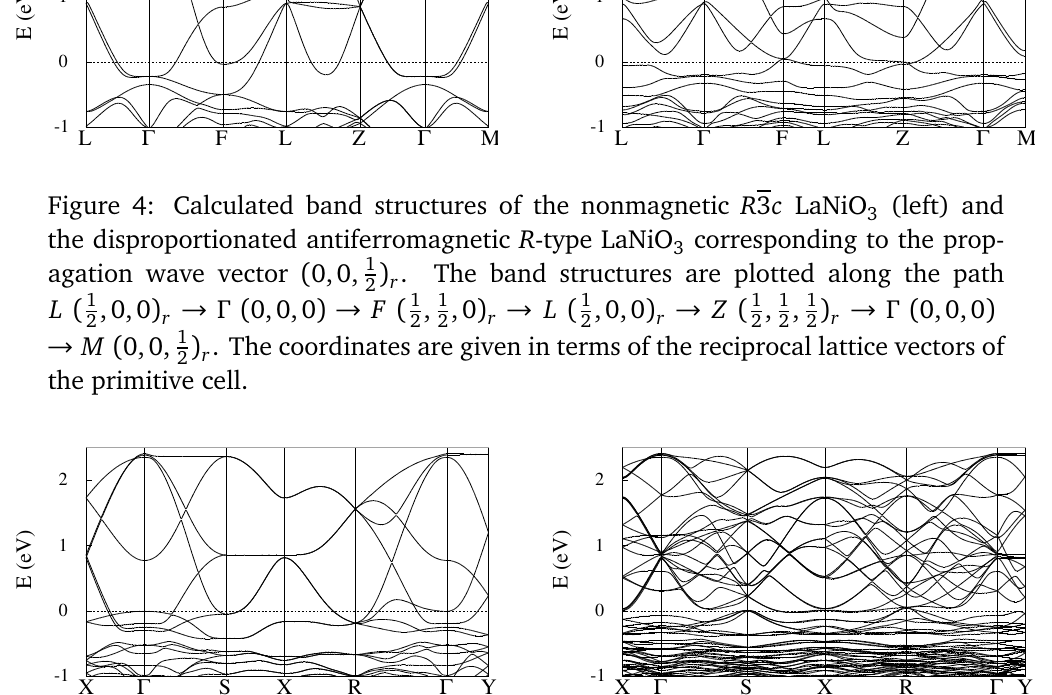
(left) and 3 corresponding to the prop- 3 , 1 ,0 ) . The band structures are plotted along the path o 2 2 ) → X ( 1 → R ( 1 ) → Γ ( 0,0,0 ,0, 1 ,0,0 ) , 1 , 1 o o o 2 2 2 2 2 2